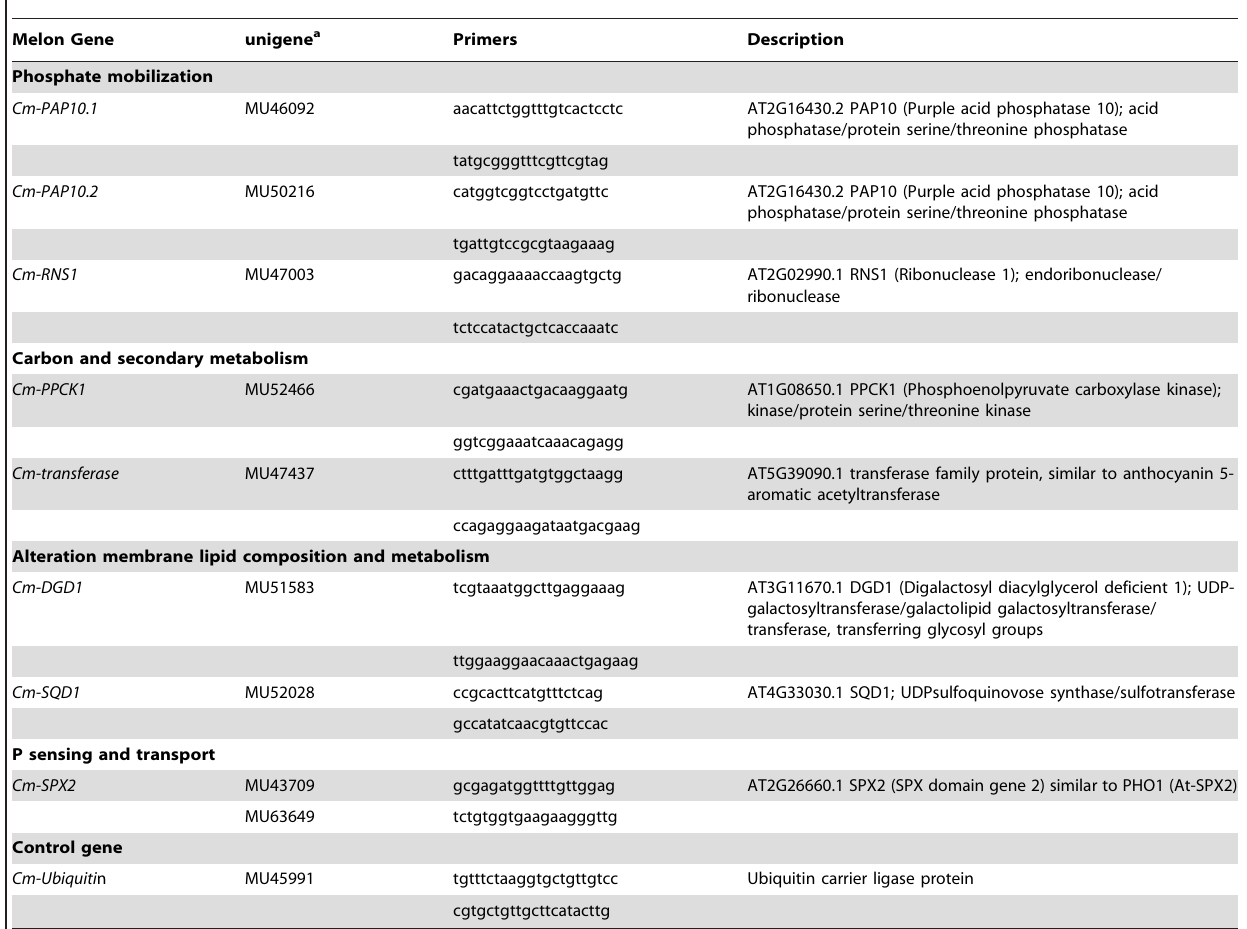
Table 3. List of genes analyzed and their function.